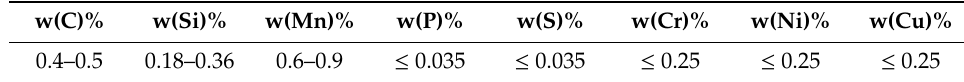
Table 3. Contents of elements in steel